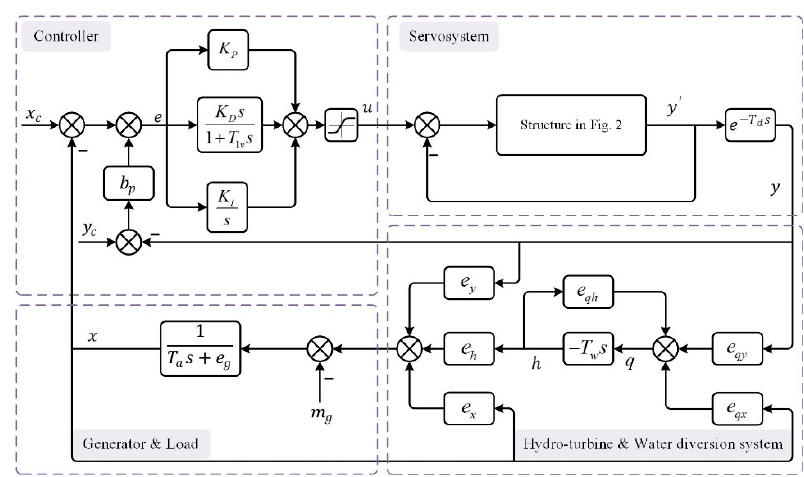
Figure 2. Partial block diagram of a servo system with nonlinear links.